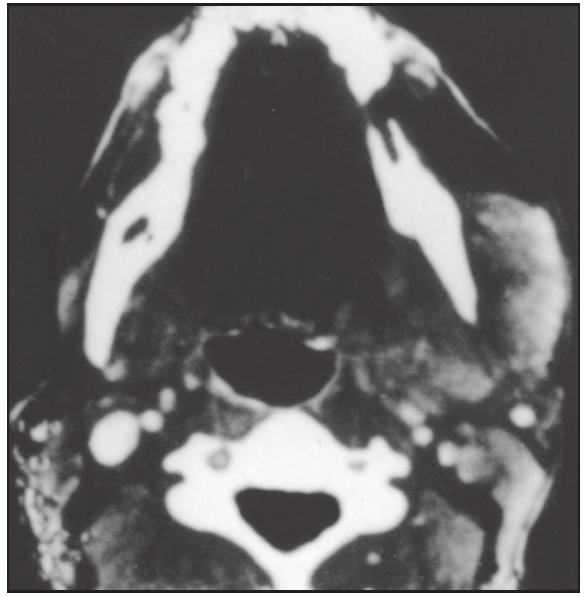
Figura 2 – Tomografia computadorizada: observação da massa tumoral em glândula submandibular